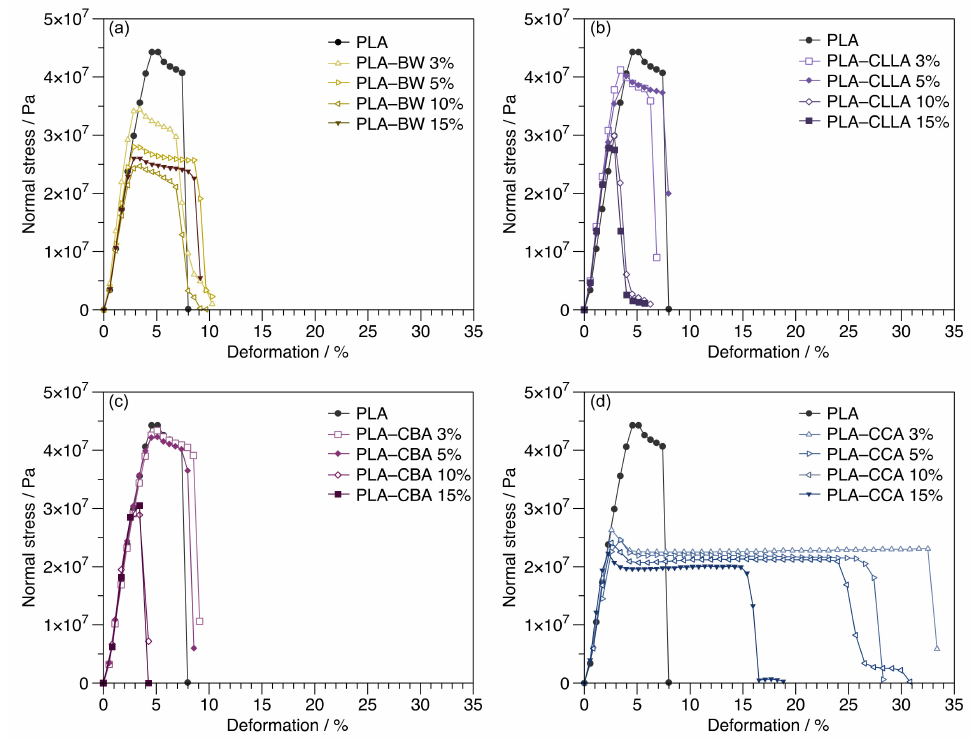
Figure 5. Stress–strain curves of PLA blends containing four different waxes at 3, 5, 10, and 15